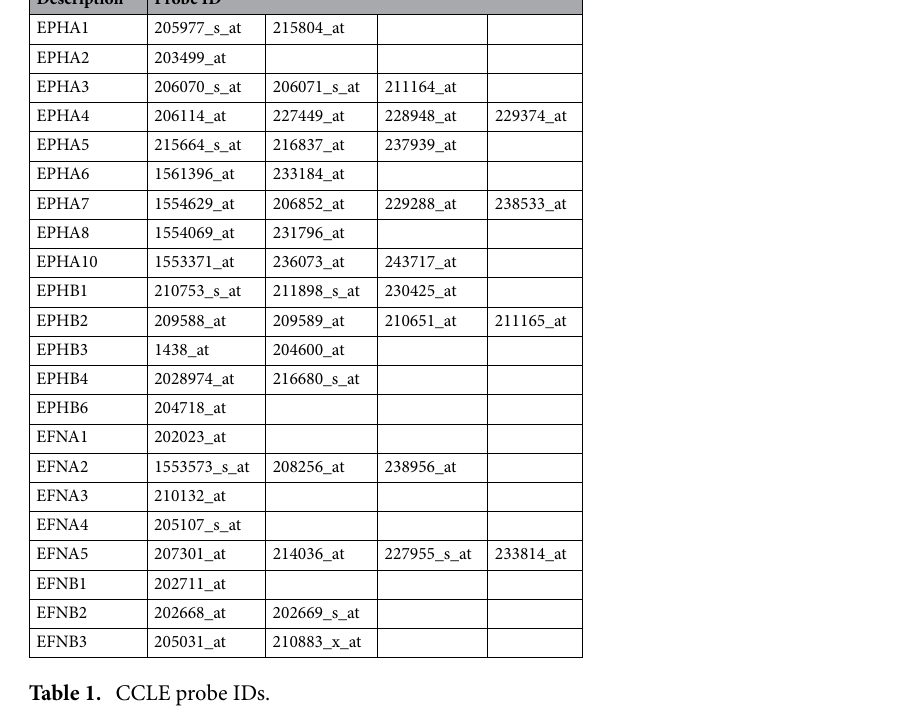
Table 1. CCLE probe